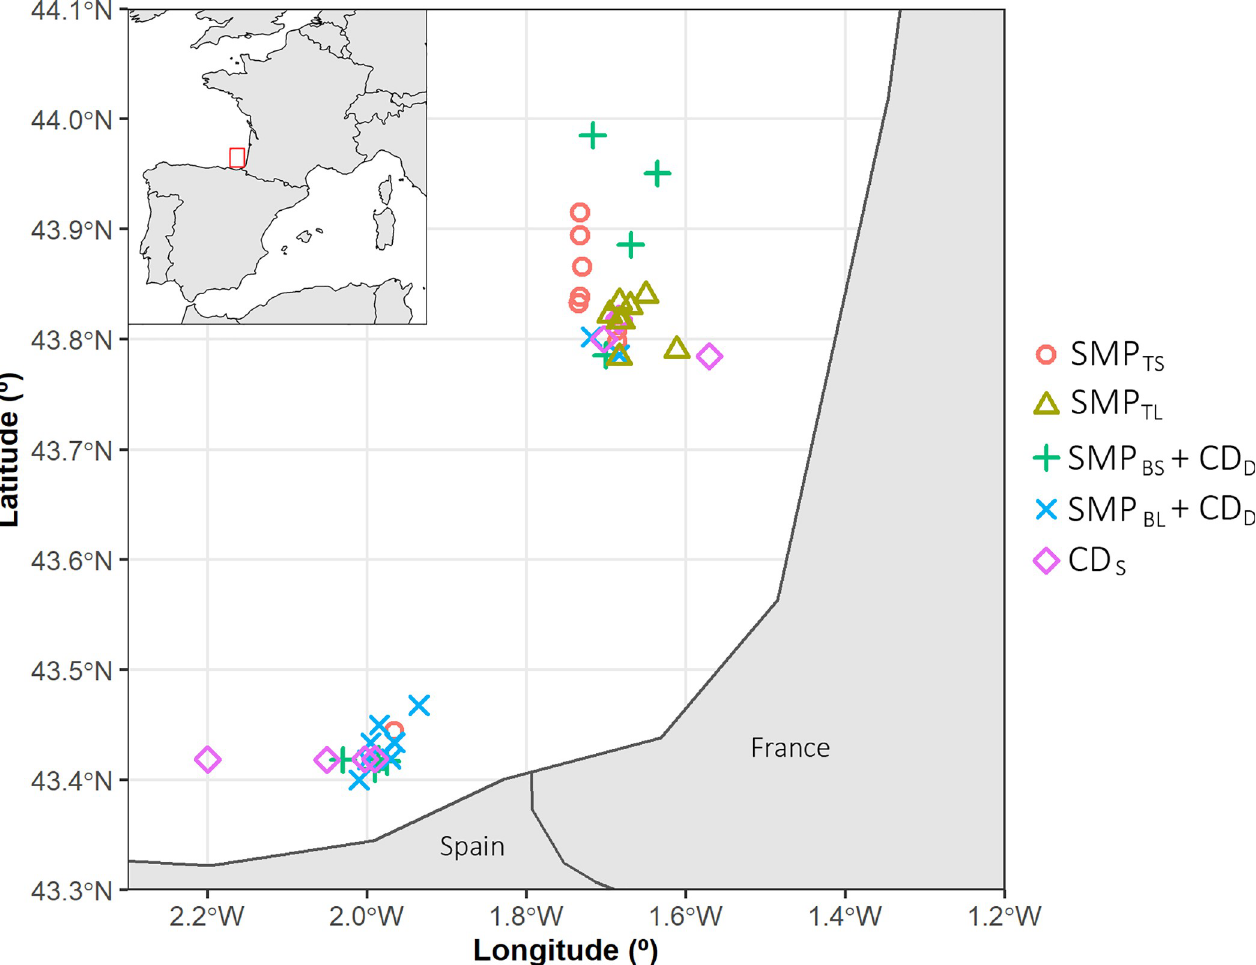
Fig 3. Sampling area and positions of the experimental hauls. Positions for SMP TS and SMP TL are also included [23, 24]. We used “ggplot2” [55] (under version 3.3.5) and “rnaturalearth” [56] (under version 0.1.0) within the R statistical environment [57] (R version 4.0.4) for